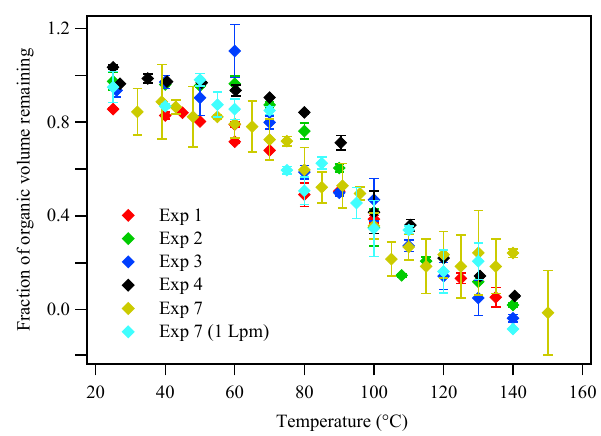
Fig. 5. Residual organic volume fraction of the organic volume for increasing temperature in the thermodenuder. Data are shown for particles selected with DMA 2 set to a 100-nm mobility diame- ter ( + 1 charge equivalent). Organic volume is calculated from the measurements of SMPS 2 (e.g., Fig. 4), including compensation for the sulfate core.